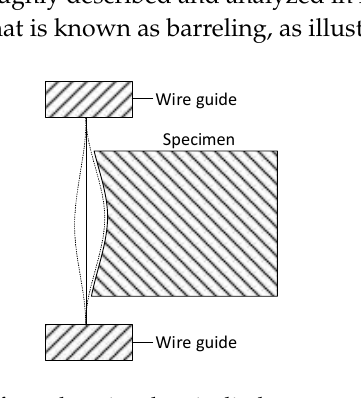
Figure 8. Illustration of barreling from the wire electric discharge machine (WEDM) cutting process which could be one of the major influences from the contour cutting process influencing the resulting experimentally obtained longitudinal residual stress field.